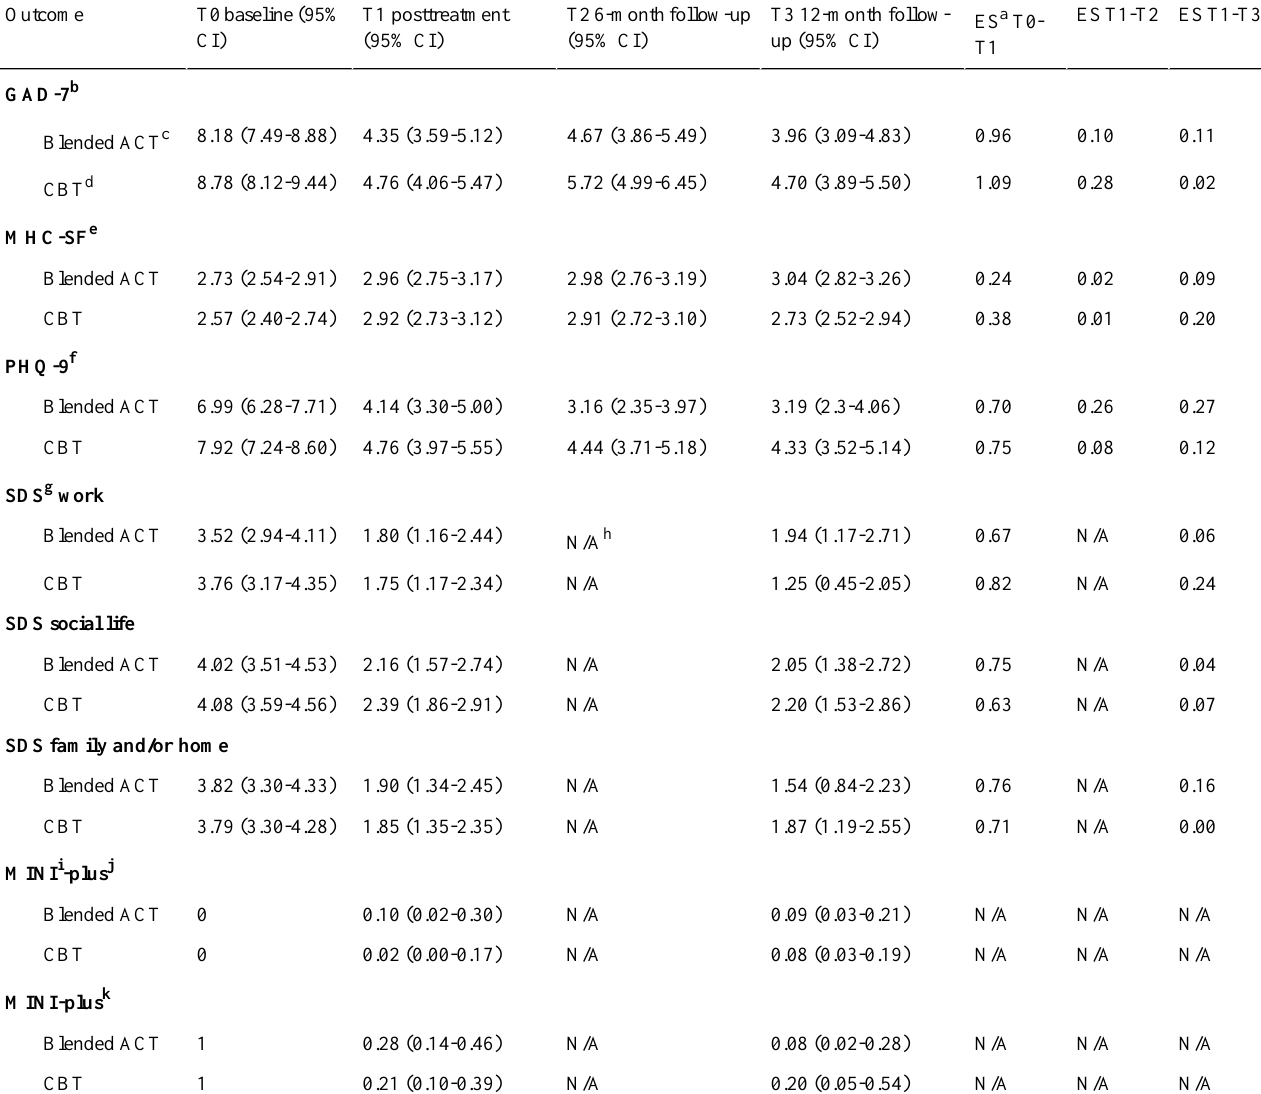
Table 4. Mixed model estimated means for the outcomes in both groups and within-group effect